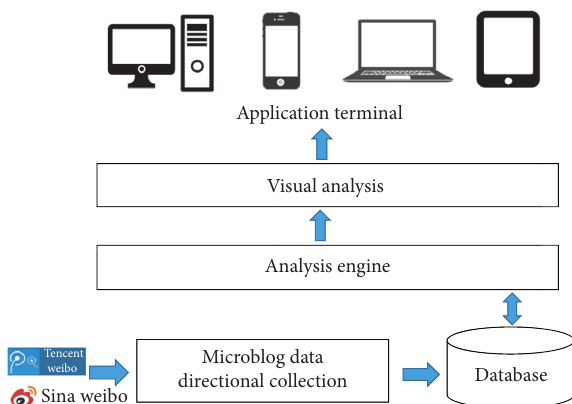
Figure 1: The structure of influence monitoring and analysis Table 2: Communication influence ranking table.